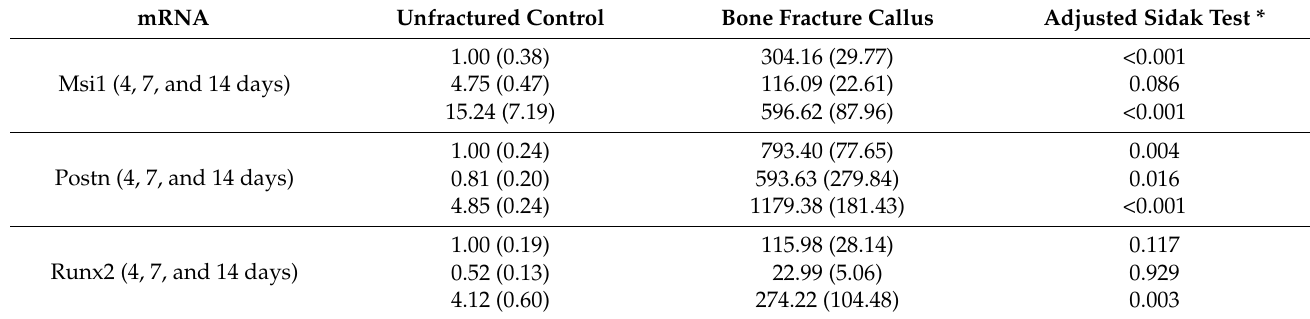
Table 4. Relative mRNA expression of Msi1, Postn, and Runx2 in the different areas under study. Note the significant differences between detection of Msi1, Postn, and Runx2 in fracture and unfractured controls, particularly at day 4 and 14. *: p values for the comparisons of unfractured control vs. callus (Sidak’s multiple comparisons post-hoc test).